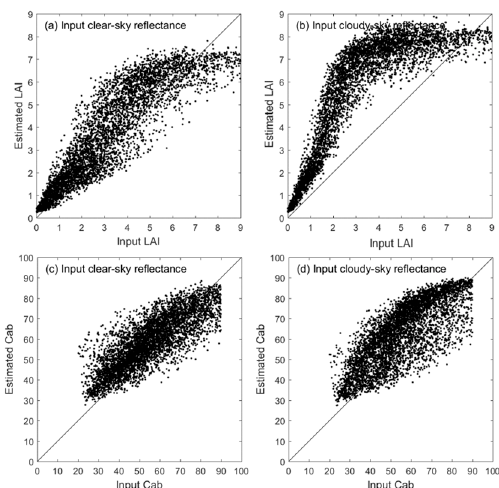
Figure 3. The regression of input LAI and estimated LAI from simulated clear-sky reflectance ( a ) and cloud-sky reflectance ( b ). ( c , d ) are corresponding for C ab (µg ∙ cm − 2 ).